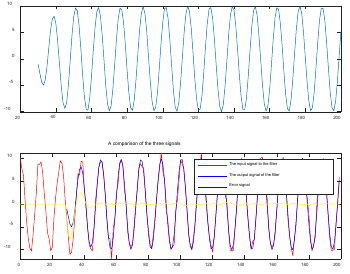
Fig. 2. Waveform recovered by LMS filter.